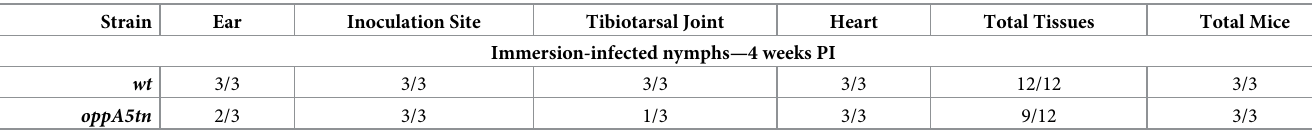
Table 5. oppA5tn positive tissue culture data from nymph fed mice. Strain